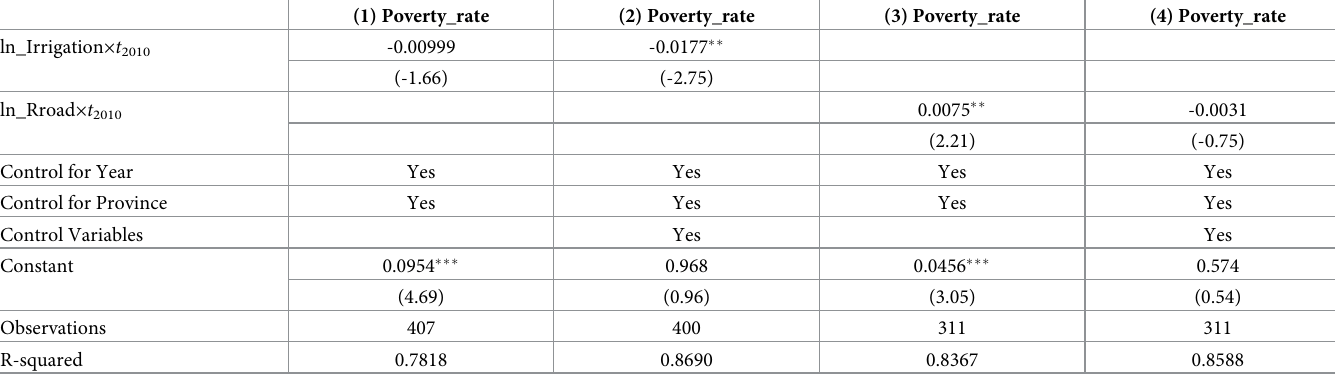
Table 4. Result of continuous model of